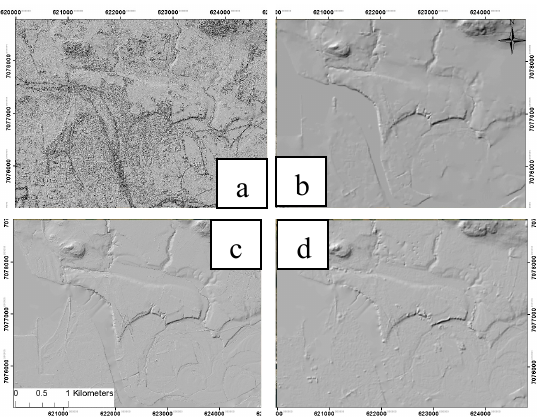
Figure 4. The DSM of the test site 3 ( a ) together with the view shed of the DTED10 ( b ), the ALSDTM ( c ) and the newly computed DTM ( d ) of the same